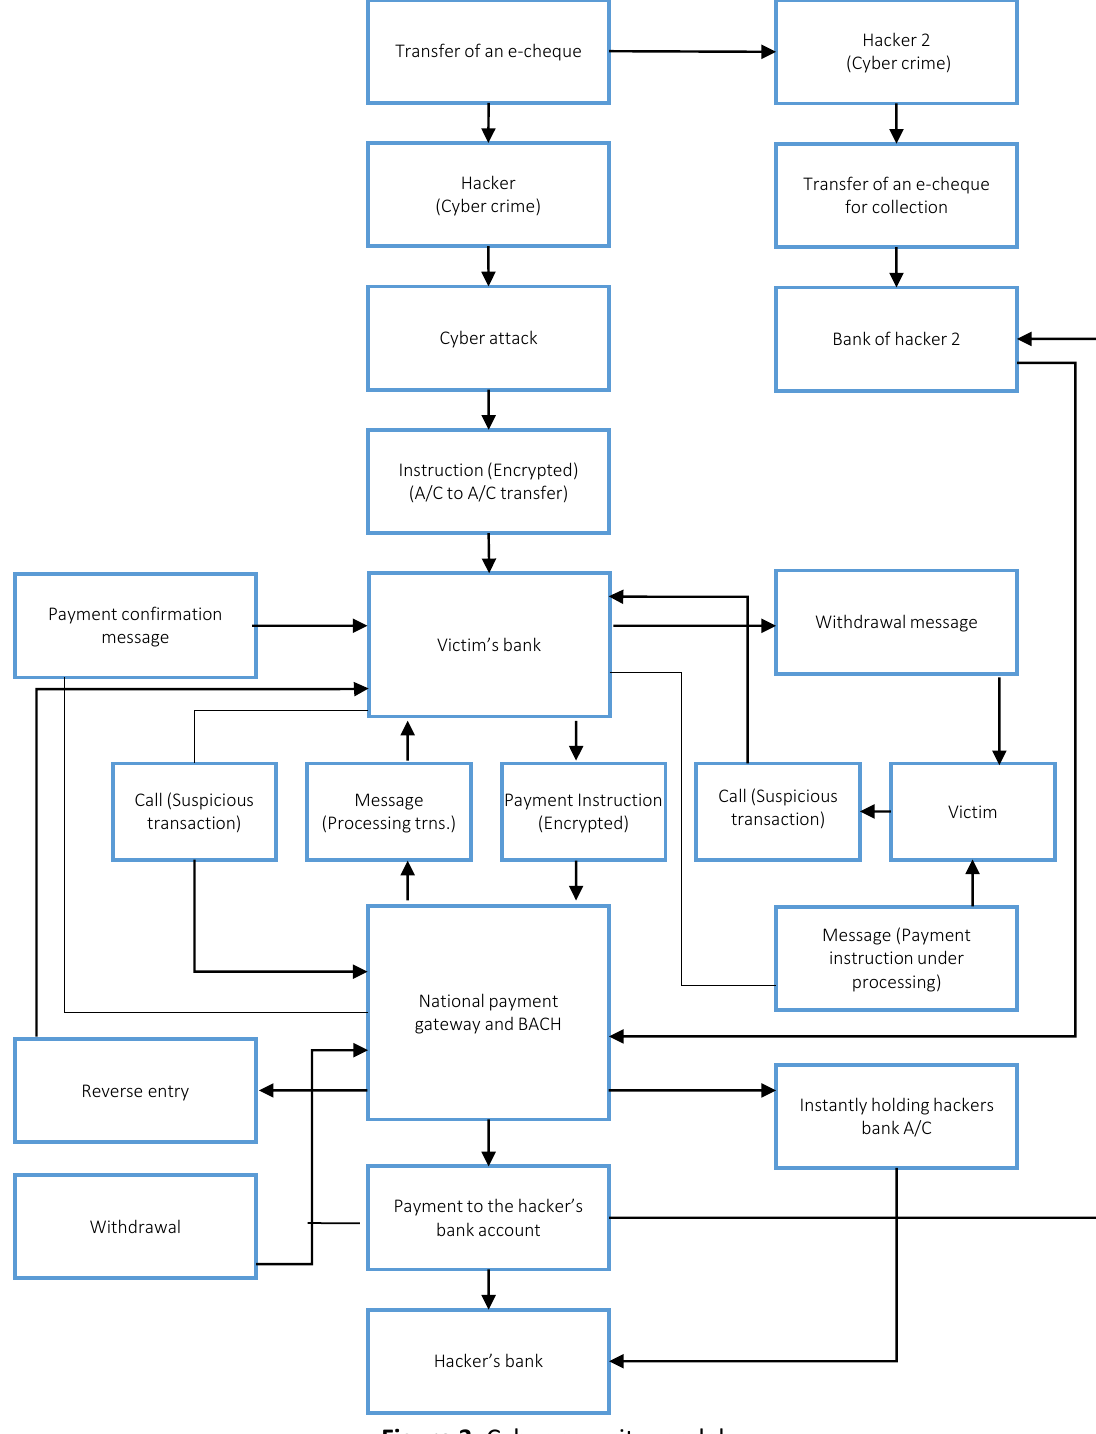
Figure 3. Cyber-security